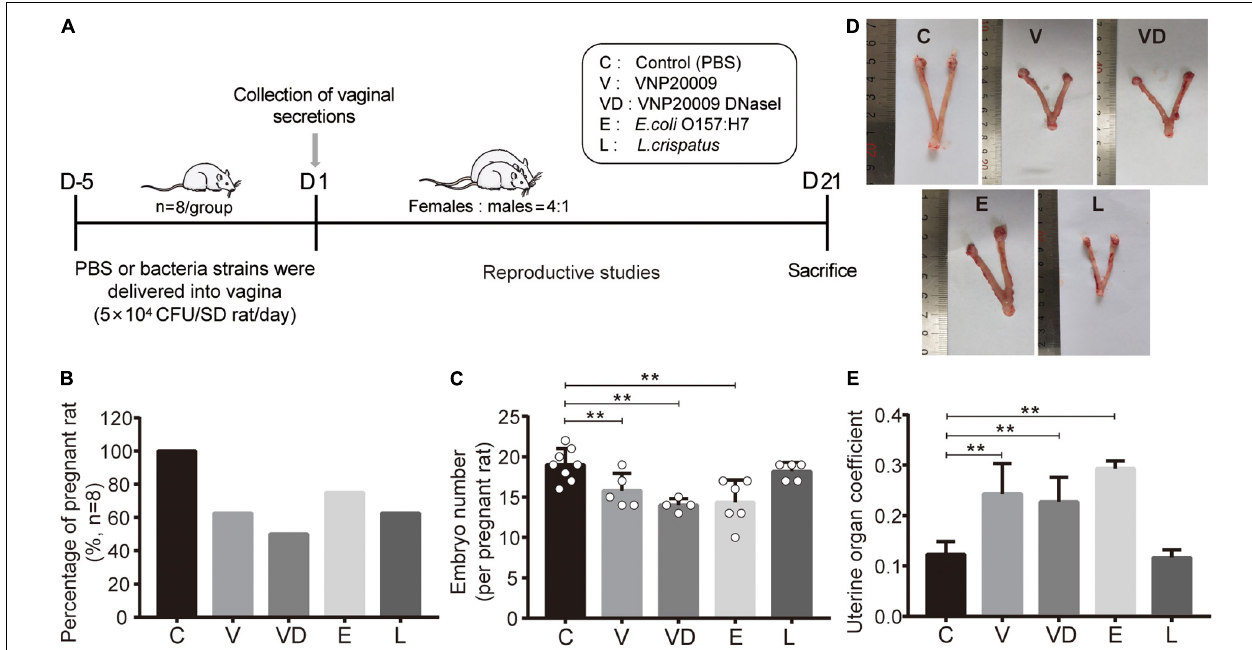
FIGURE 3 | The inhibitory effect of L. crispatus on sperm reduced the pregnancy rates and had no reproductive impairment. (A) Scheme of experimental timeline and procedures. (B) Fertility outcome about pregnancy rates and (C) embryo number about the female rats of the indicated treatment groups. (D) Representative gross images and (E) organ coefficients of the uterus are shown in different treatment groups. The data represent means ± SD of eight to 10 animals. * P < 0.05, ** P < 0.01. SD, standard deviation; C, control; V, VNP20009; VD, VNP20009 DNase I; E, E. coli O157:H7; L, L. crispatus